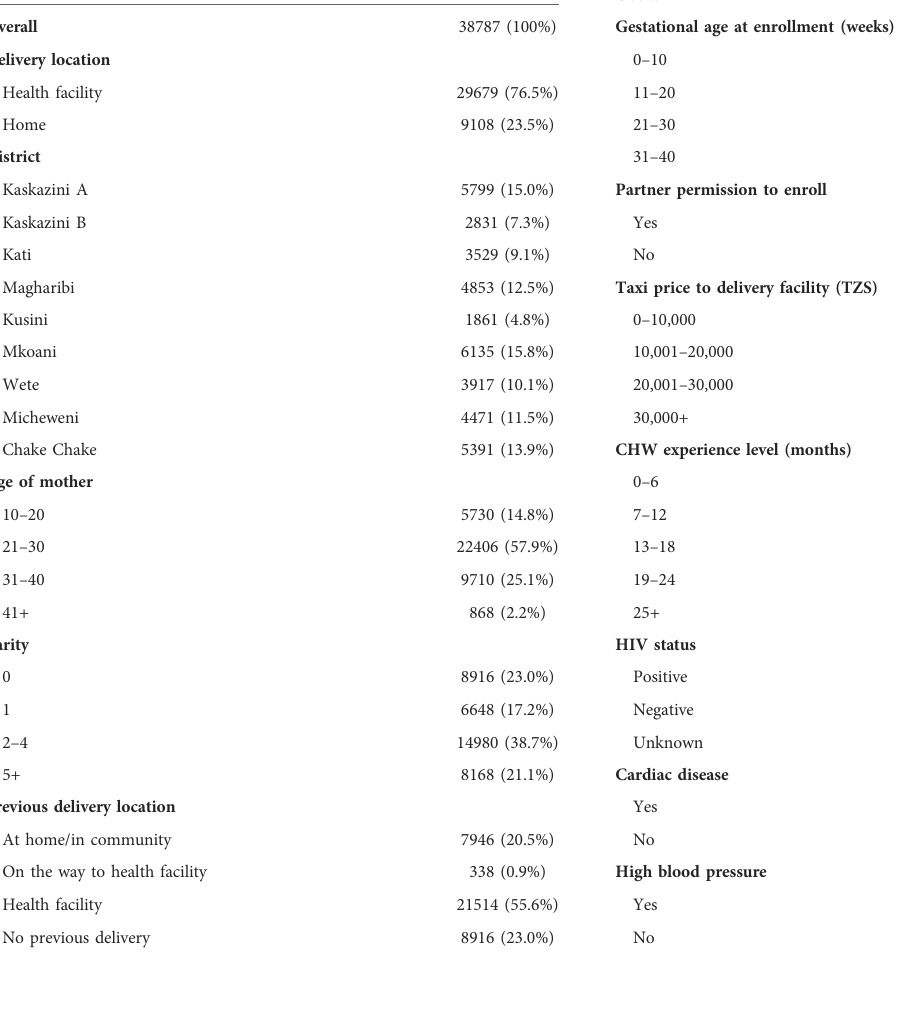
TABLE 2 Programmatic and self-reported clinical characteristics ( N